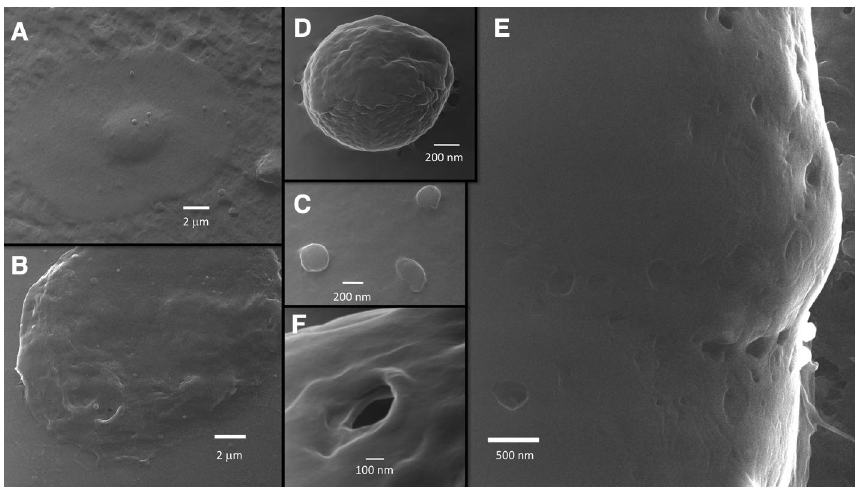
Figure 8. Vesicles and caveolae in SARS-CoV-2 infected cells. Vesicles and caveolae are seen in infected cells at various magnifications (magnification in ( A,B ) × 10,800; ( B,C ) × 135,000; ( D ) × 180,000; ( E ) × 135,000; ( F ) ×